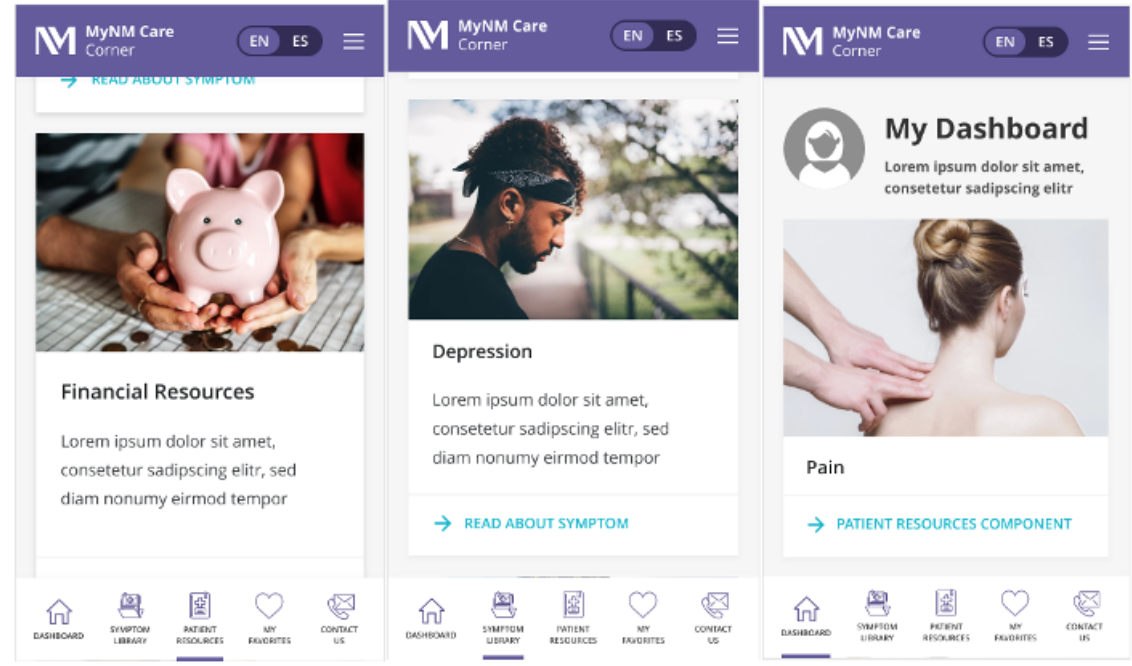
Figure 1. Screenshots of the mobile-friendly My NM Care Corner